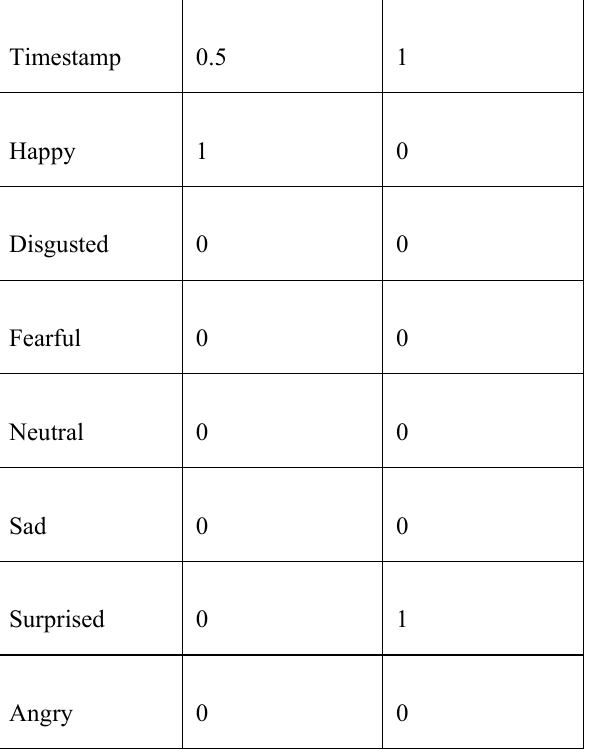
Table 1. Output from video processing